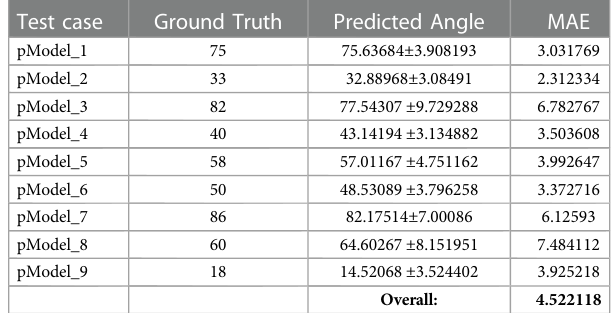
TABLE 3 Angle prediction results and MAE (mean average error) for penile model images. Test case